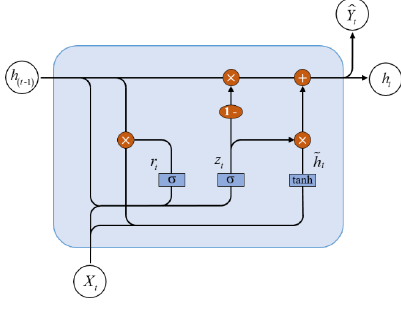
Figure 5. The structure of multi-layered GCN.